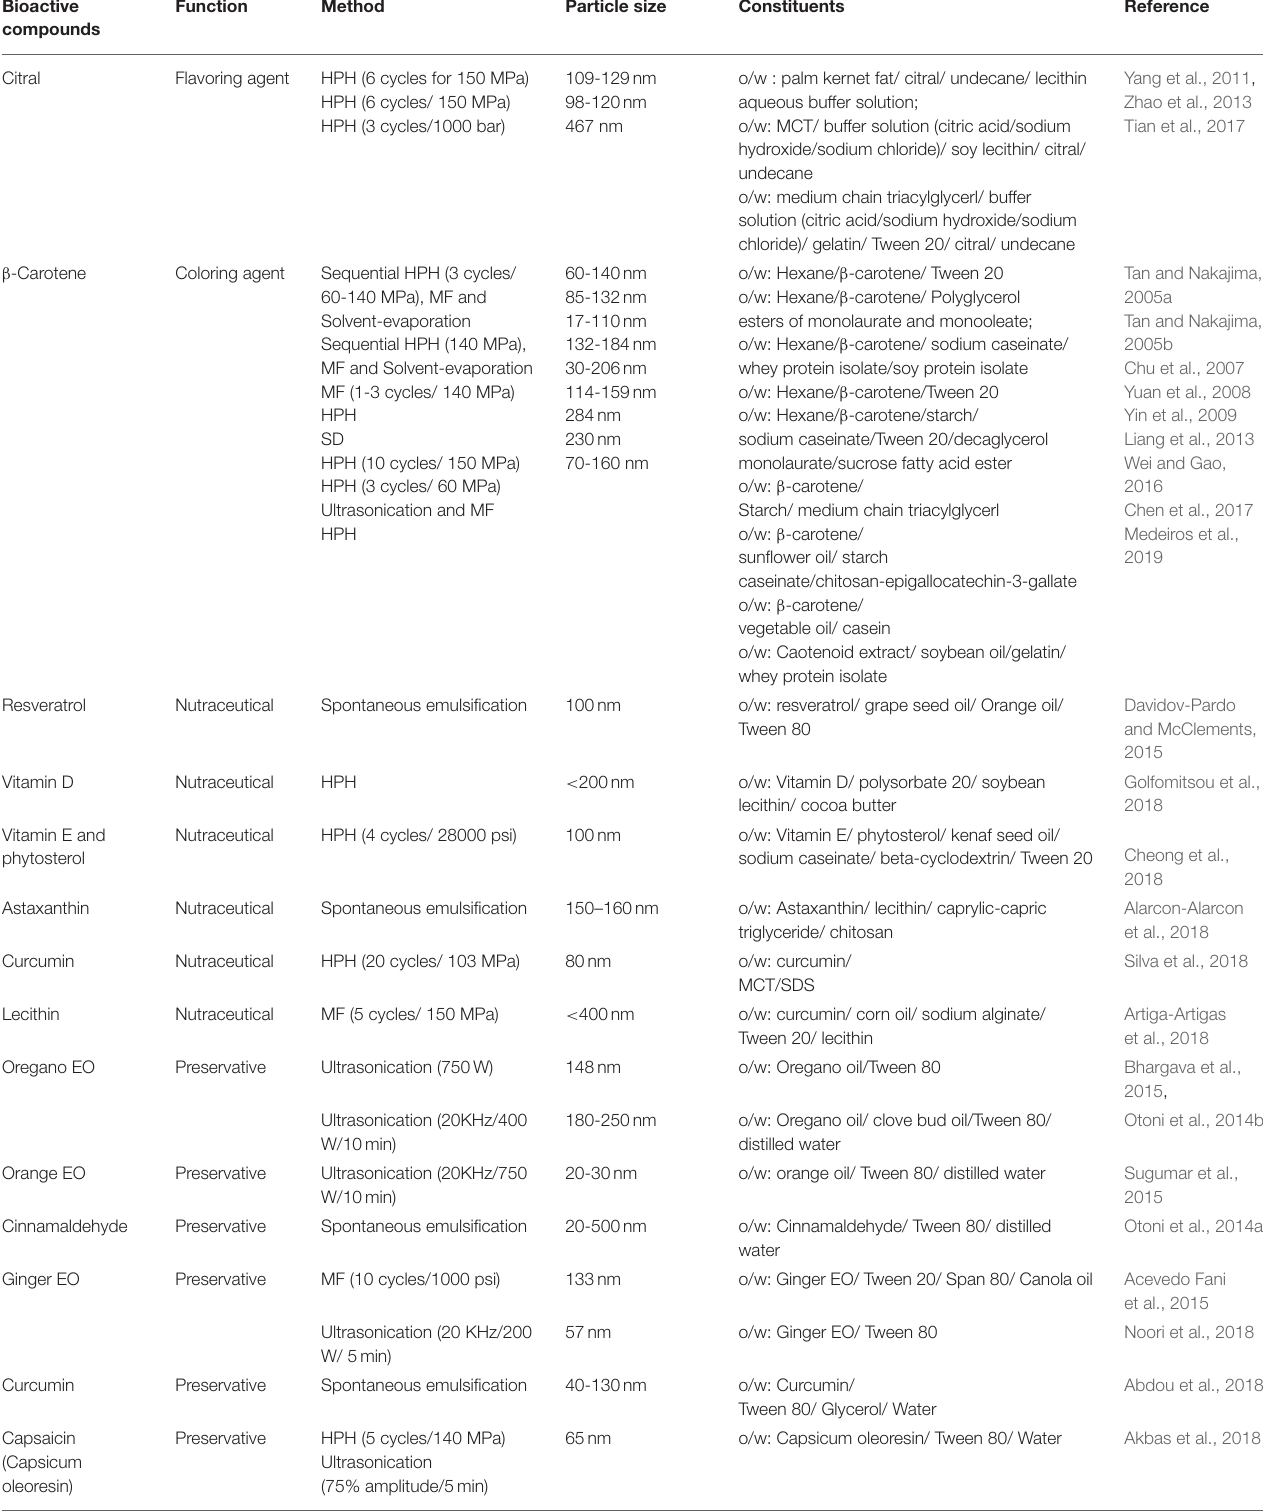
TABLE 3 | Functional compounds encapsulated into nanoemulsions for food